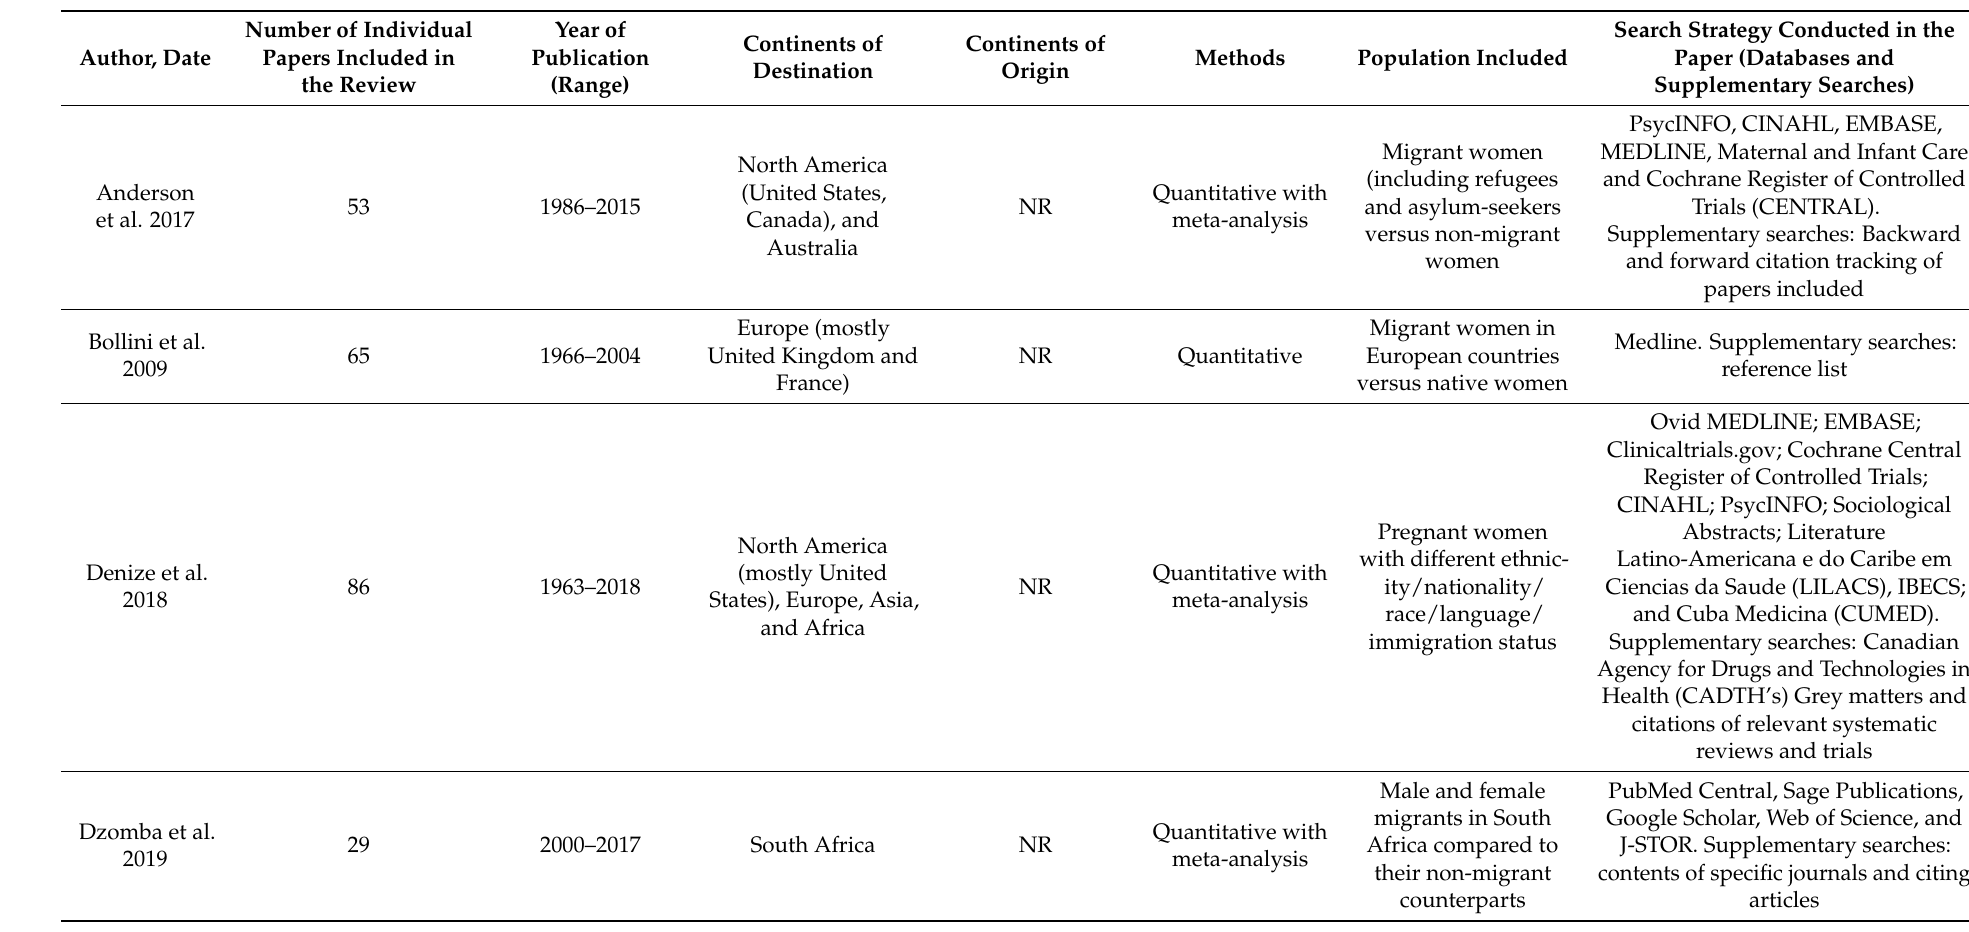
Table 2. Systematic literature reviews and meta-analyses